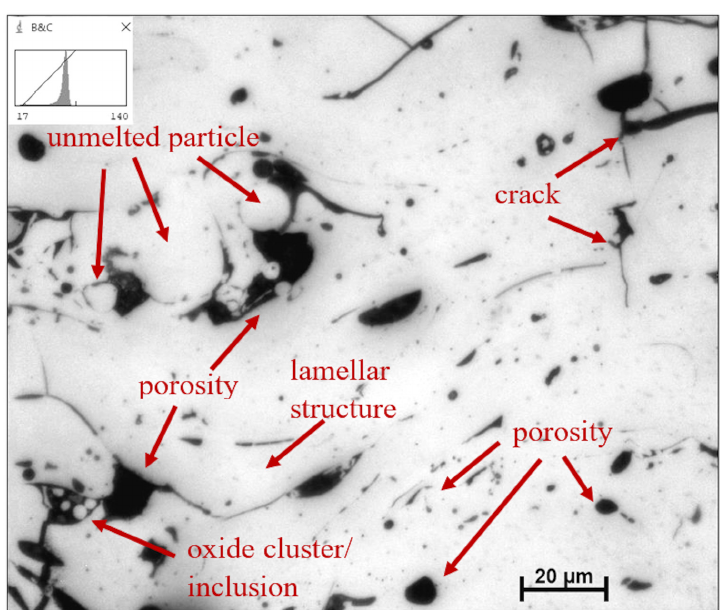
Figure 1. Coating cross-section. The dark tonal regions are pores and cracks. Unmelted particles were also observed.